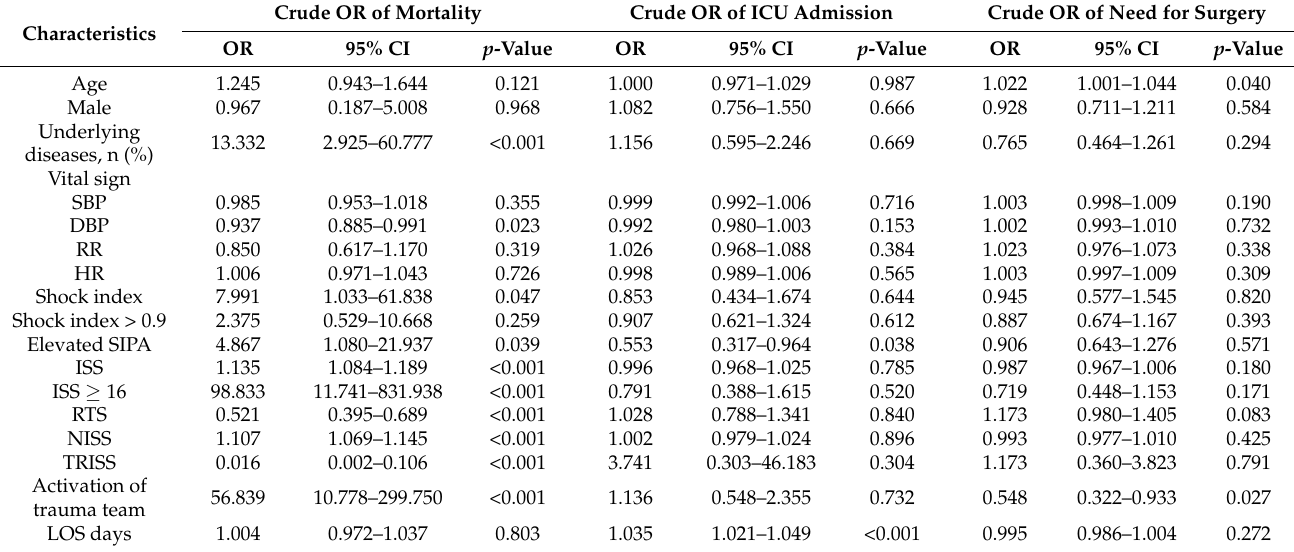
Table 4. Unadjusted odds ratio for mortality related to in-hospital